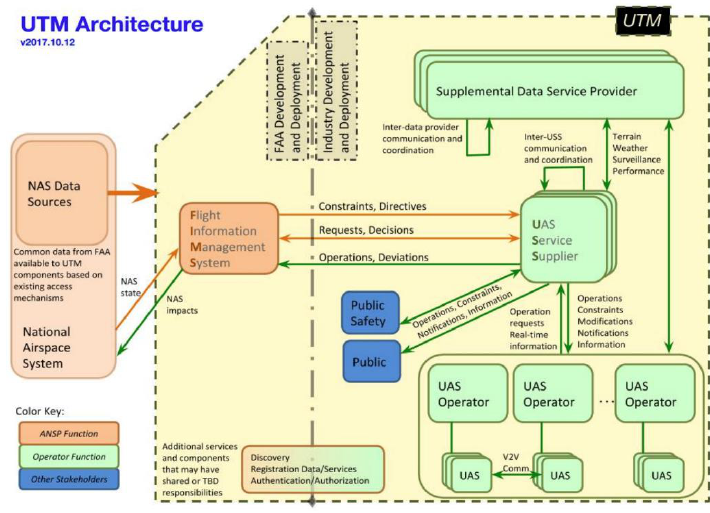
Figure 4. UTM architecture [19] (p. 9).